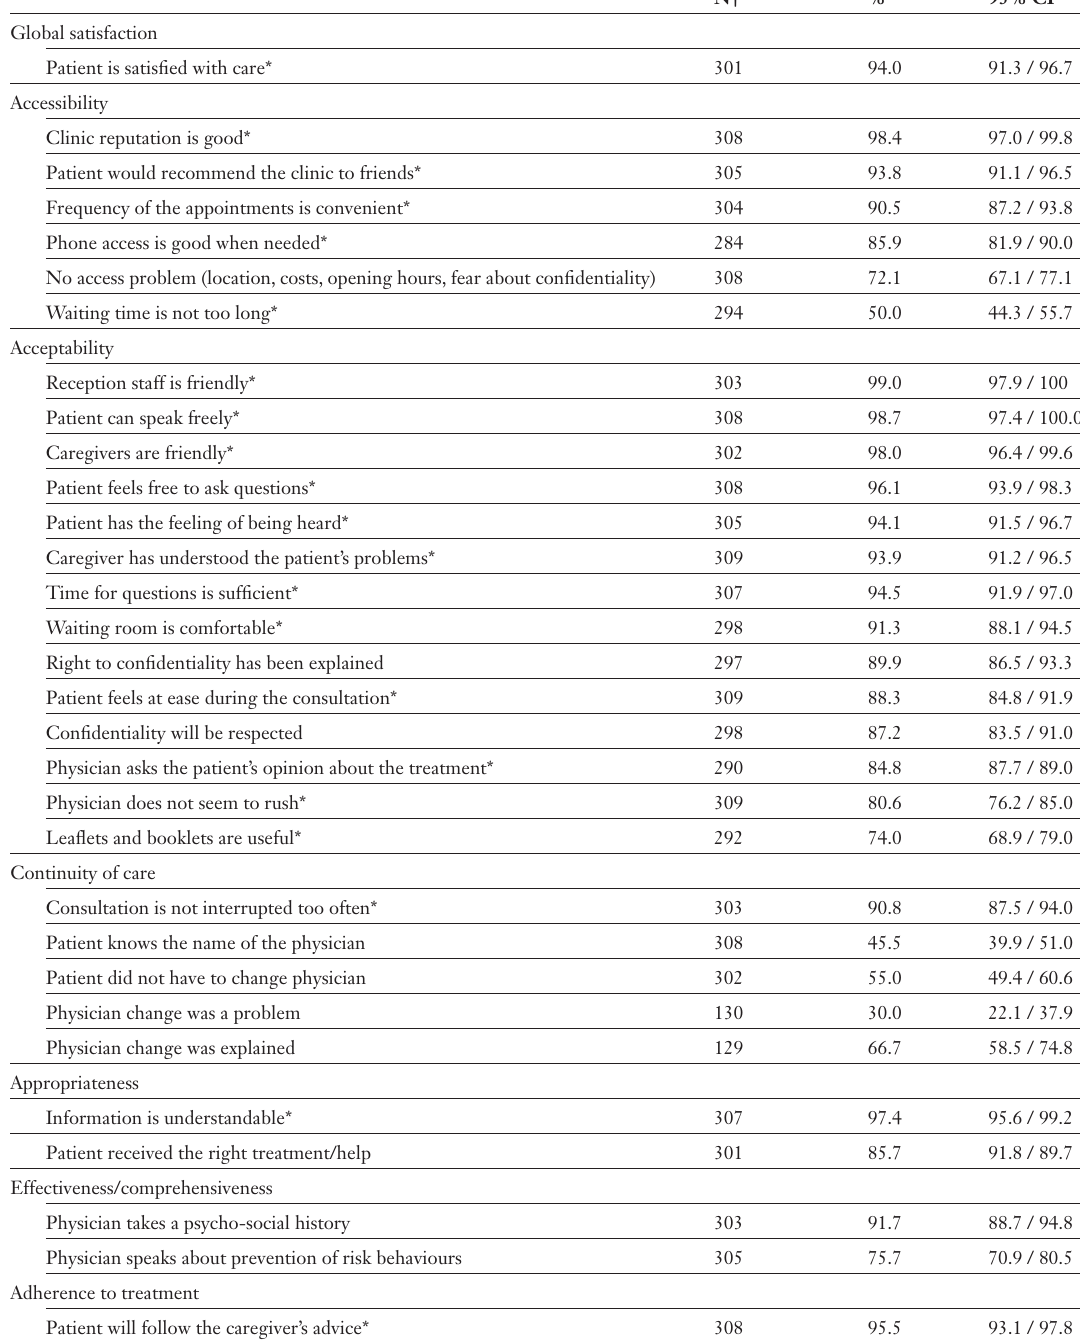
Table 2 Descriptive analysis of satisfaction deter-